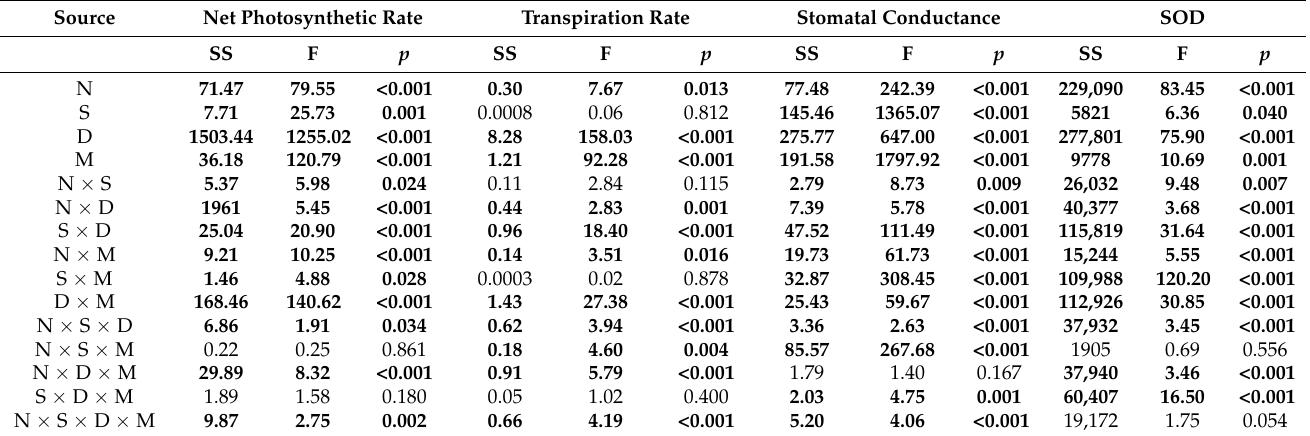
Table 3. The effects of inorganic nitrogen PM 2.5 (N), species(S), days in fumigation (D), experimental month (M), and their interactions on the net photosynthetic rate, transpiration rate, and stomatal conductance of Iris germanica L. and Portulaca grandiflora Hook. The linear mixed-effects model used the Kenward–Roger method as a denominator for degrees of freedom.